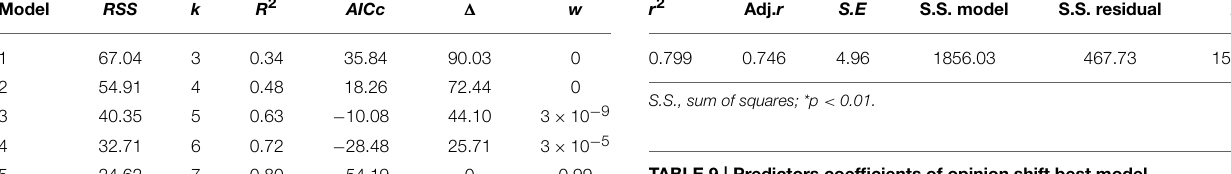
TABLE 7 | Multiple regression models comparison by means of AICc. Model